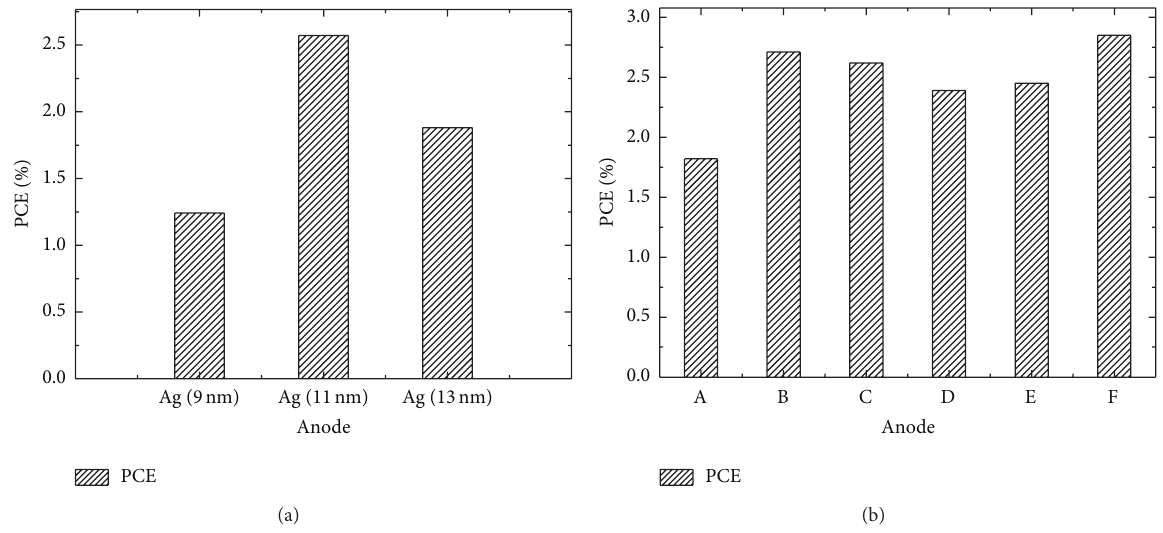
Figure 2: The PCE of ITO-free reference OSCs fabricated on the (a) Ag or (b) MoO 3 /Ag anodes. For comparison, the PCE of the ITO-based reference OSC is also shown in (b). The characters A, B, C, D, E, and F on the 𝑋 axis of (b) indicate MoO 3 (2nm)/Ag (7nm), MoO 3 (2nm)/Ag (9nm), MoO 3 (2 nm)/Ag (11nm), MoO 3 (10nm)/Ag (9 nm), MoO 3 (10nm)/Ag (11nm), and ITO anode,